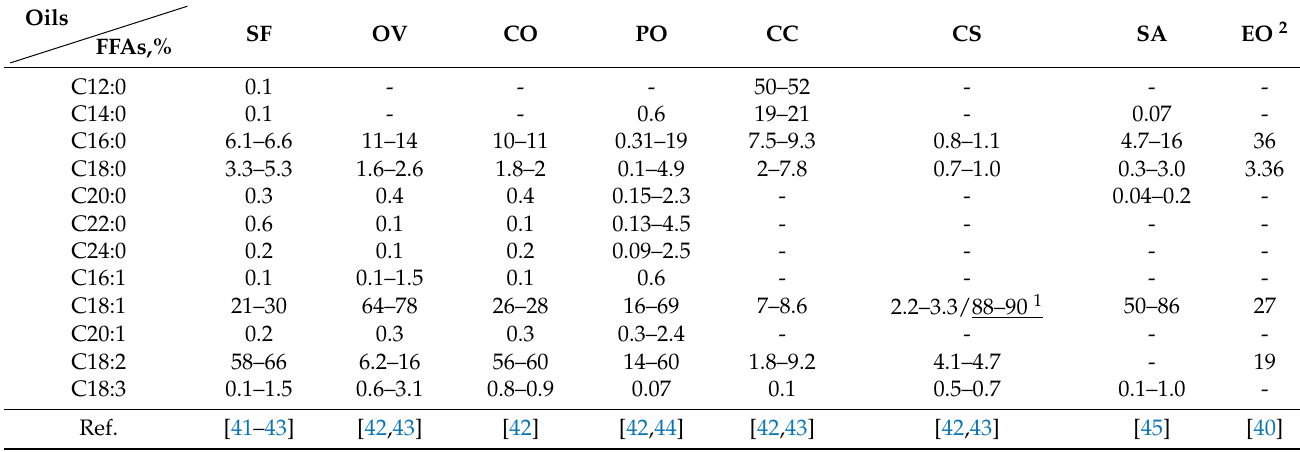
Table 2. Bibliographic information on the fatty acid composition of selected